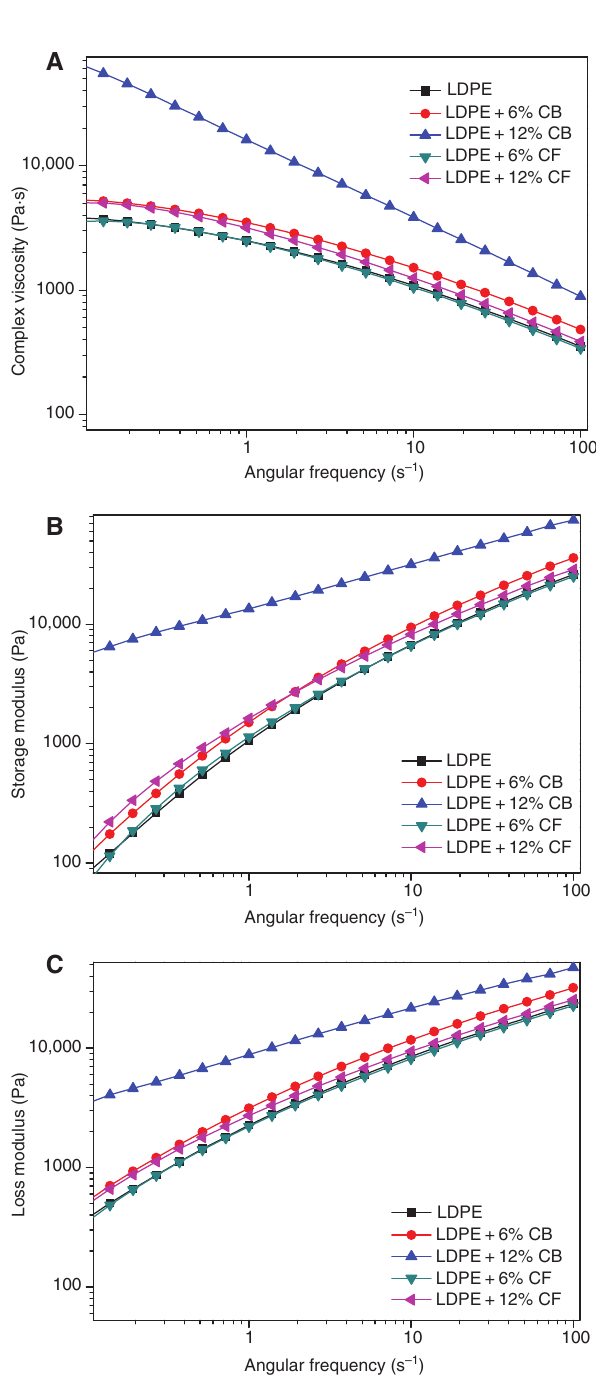
Figure 7: Dynamic rheological curves of LDPE/CB and LDPE/CF composite with different filler